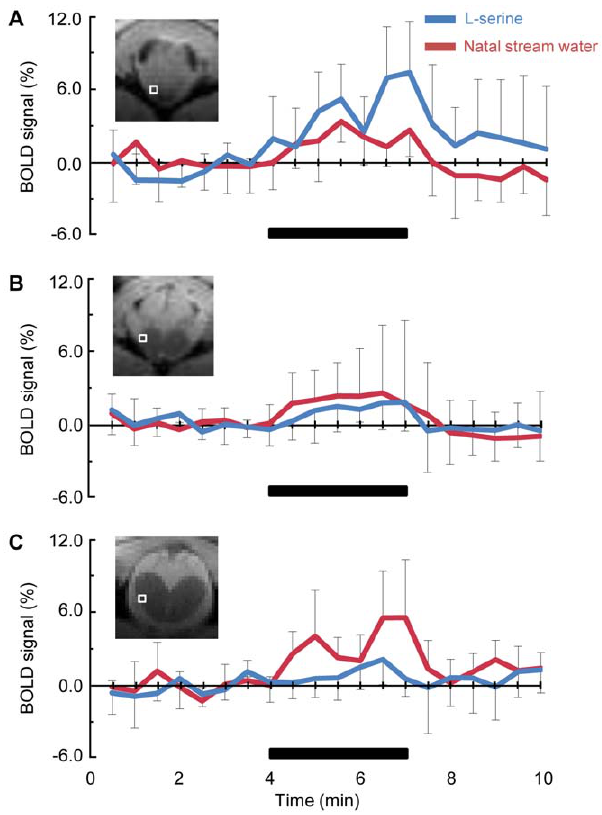
Figure 2. Time course of the BOLD signal changes induced by L-serine and natal stream water in the activation area. A : olfactory bulb corresponding to Fig. 1Ci; B: telencephalon correspond- ing to Fig. 1Cii; C: telencephalon corresponding to Fig. 1Civ. These responses are averaged for six stimulus paradigms from the same fish. The locations of each area are shown as boxes in the insert MRI images. The bars indicate the stimulus period (3 min).